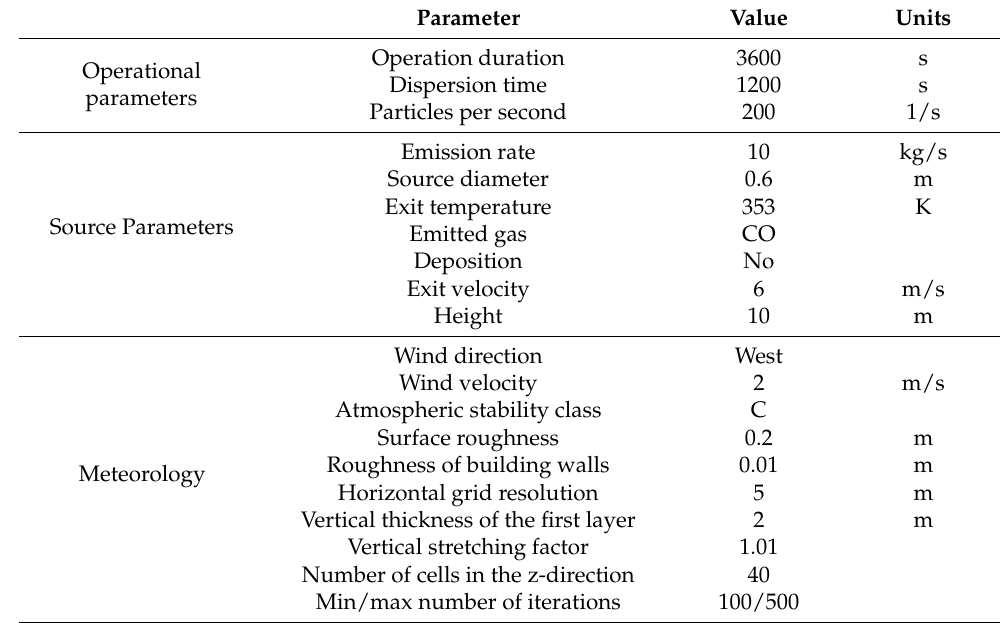
Table A1. List of parameters used for the GRAL